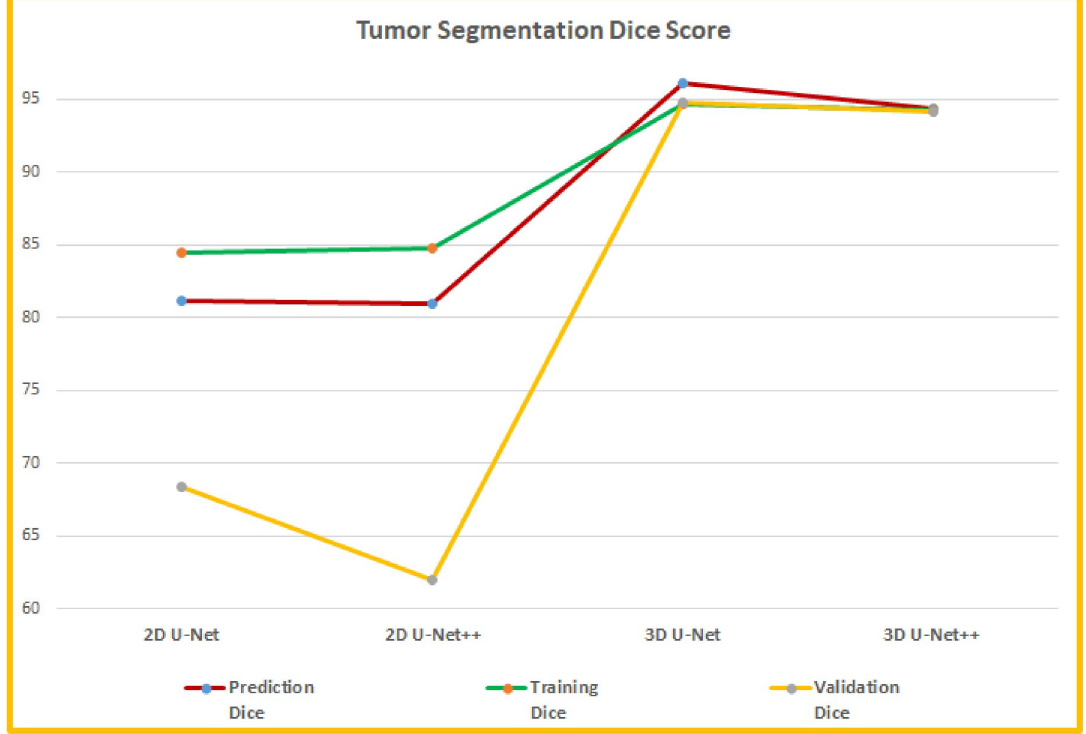
Fig 24. Performance comparison for tumor segmentation